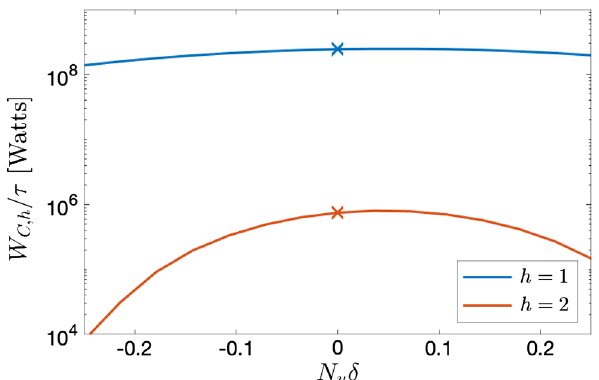
FIG. 5. Coherent emission peak power at different values of ð 1 − δ Þ . Same parameters as Fig. 4 undulator detuning, K → K h ¼ 20% and I ¼ 1 kA, but with σ ¼ 25 μ m ( N ¼ 1 ) for with b 0 h x LCLS-II e-beams. Each x marks the coherent power emitted at zero detuning, calculated from Eq.